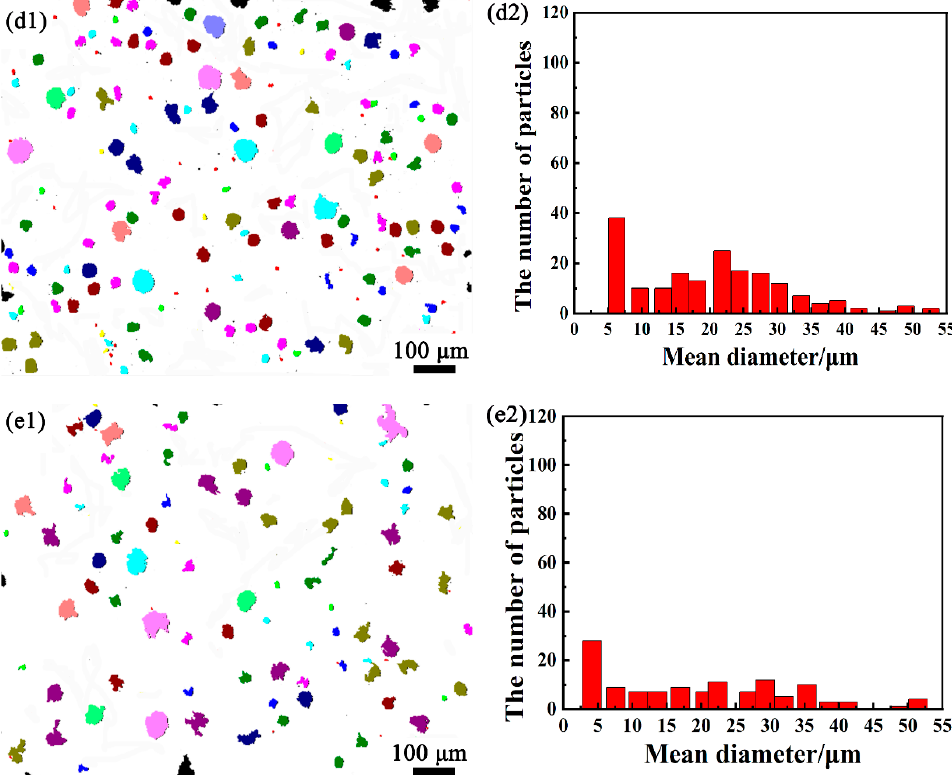
Figure 3. Nodular graphite distribution and nodule number/mm 2 for different nodular graphite specimens: ( a1 , a2 ) ADI 60, ( b1 , b2 ) ADI 75, ( c1 , c2 ) ADI 95, ( d1 , d2 ) ADI 120, ( e1 , e2 ) ADI 150.